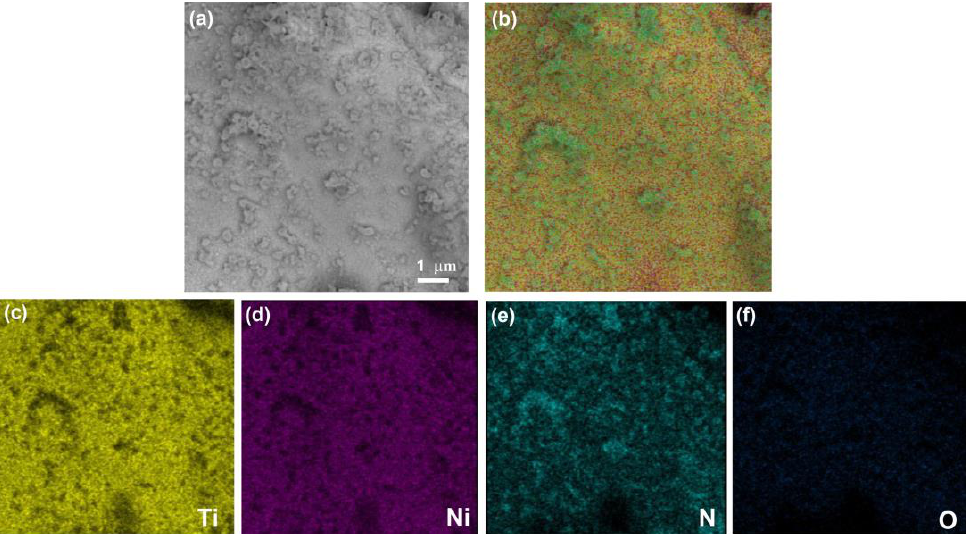
Figure 5. SEM images ( a ) and EDS layered image ( b ) of the surface morphology of the porous TiNi with bambusuril deposited under vacuum with distribution maps of Ti ( c ), Ni ( d ), N ( e ), and O ( f ) elements. Table 1. SEM-EDS of the porous TiNi with bambusuril deposited under vacuum. Elements